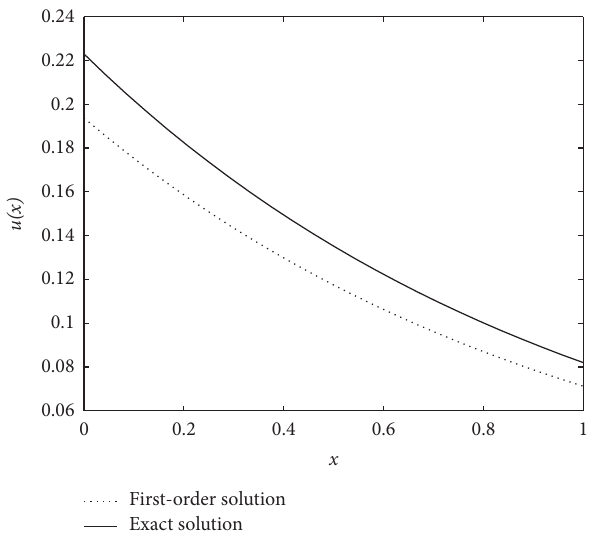
Figure 1: Convergence of first-order solution of 𝑢(𝑥,𝑦, 𝑡) at 𝑡 = 𝑦 = 1